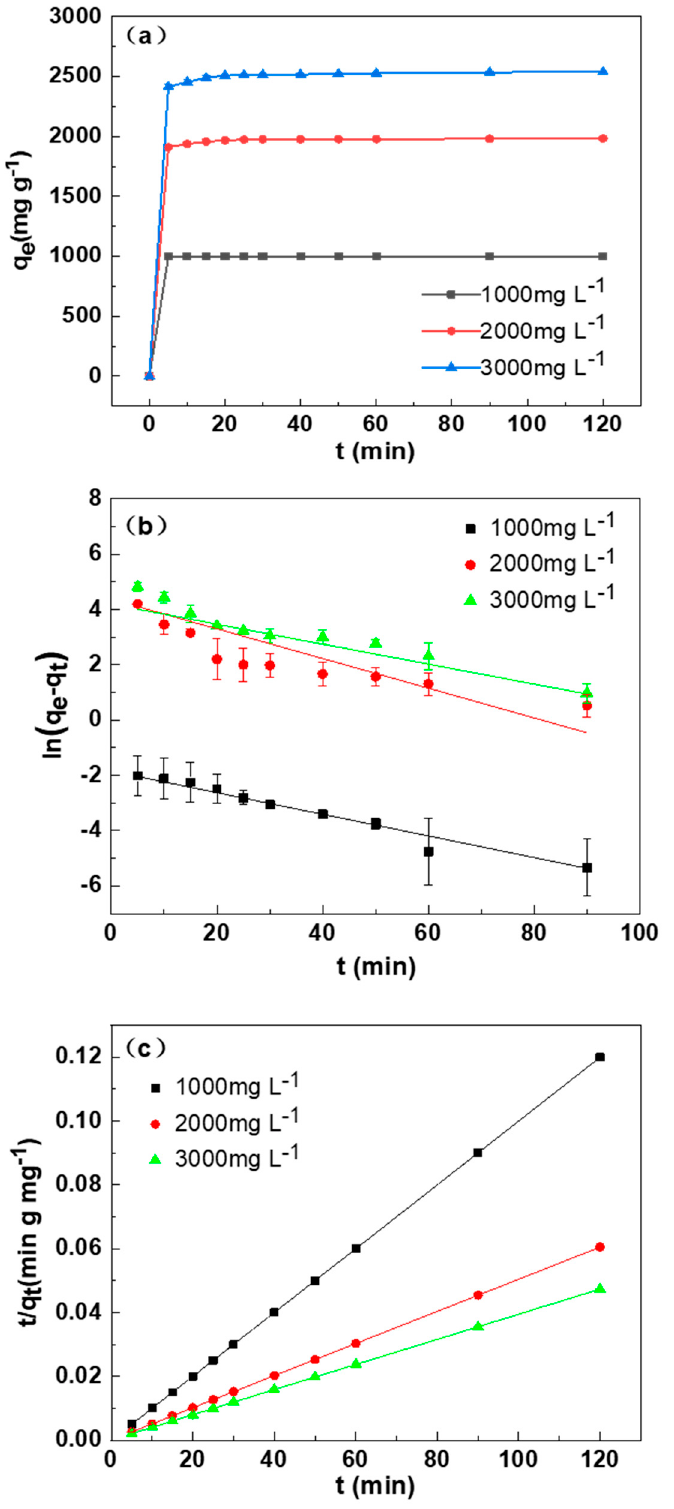
Figure 6 . ( a ) Effect of the contact time on methylene blue (MB) adsorption by SDB-6-K. ( b ) The pseudo-first-order and ( c ) pseudo-second-order for the MB adsorption by SDB-6-K. Conditions: T = 298 K; m = 0.025 g; V = 25 mL; C 0 = 1000, 2000, 3000 mg L − 1 .